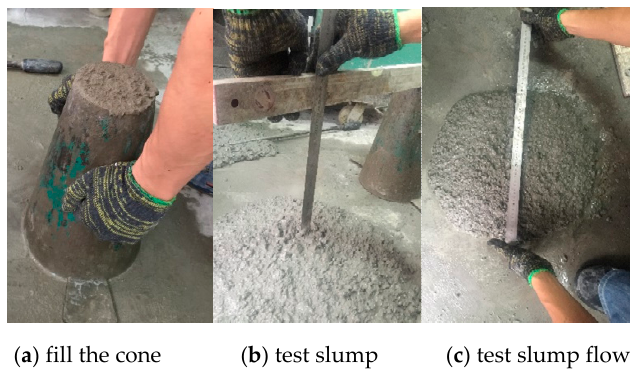
Figure 4. Test of fluidty.